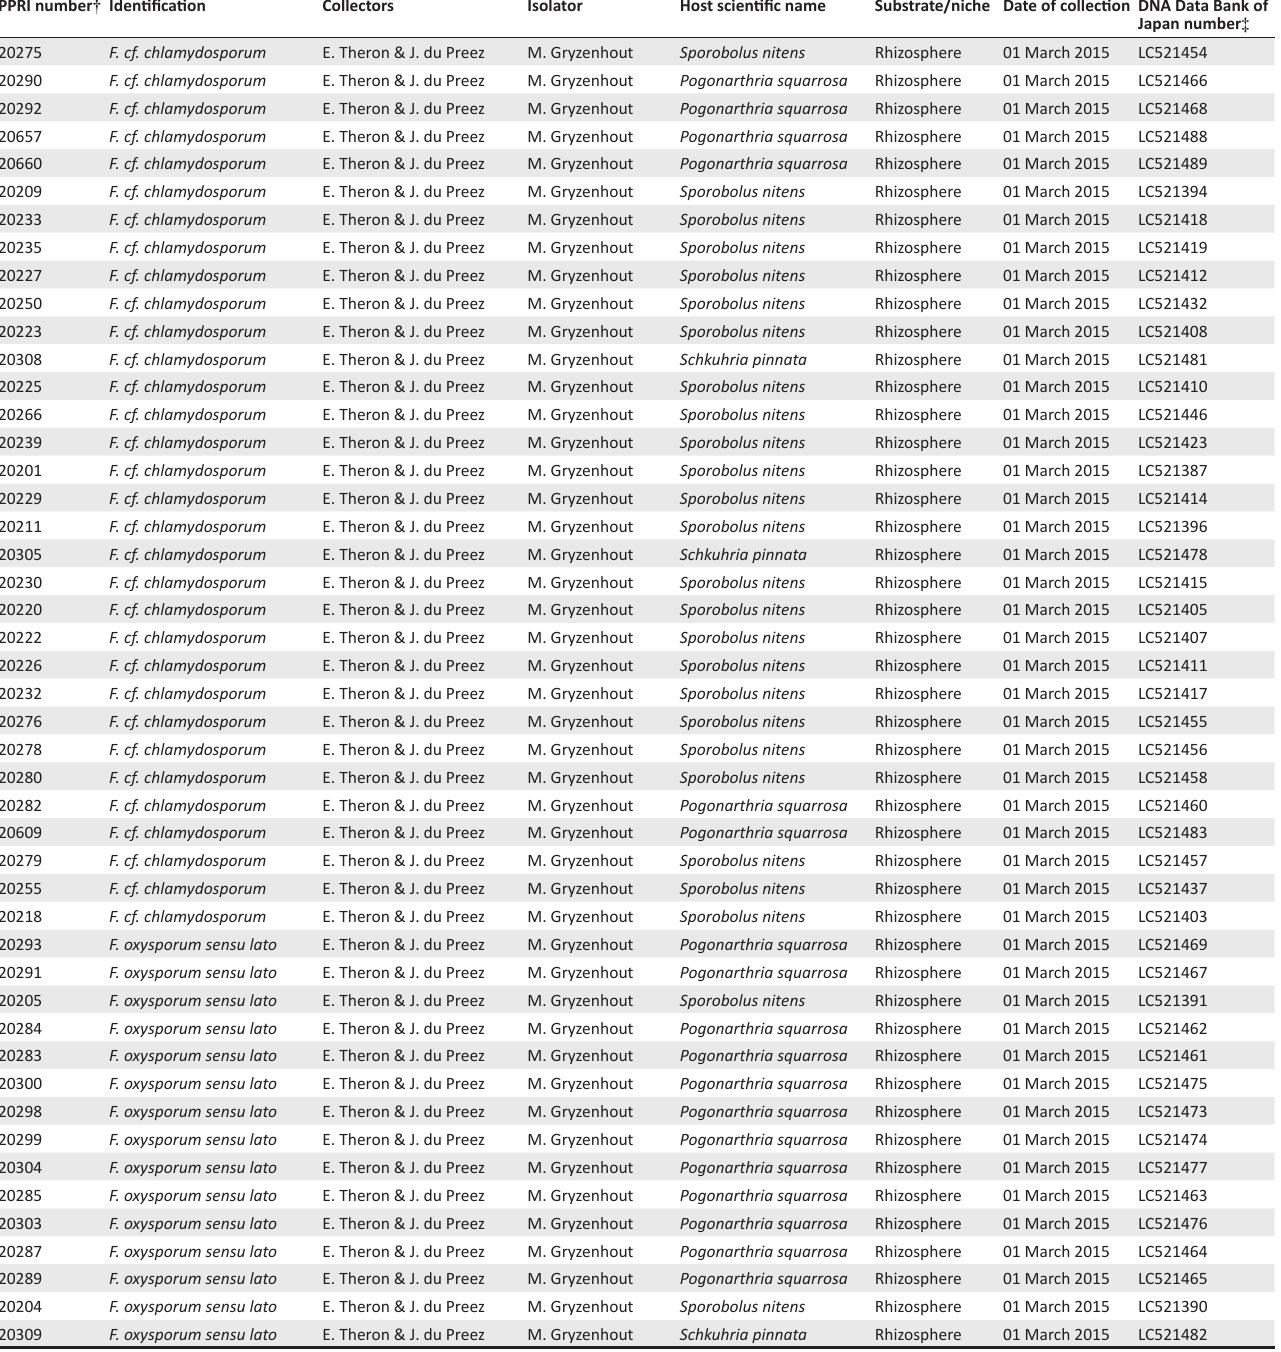
TABLE 1 (Continues...): List of Fusarium isolates identified in this study that originated from the Stevenson-Hamilton catena in Kruger National Park, South